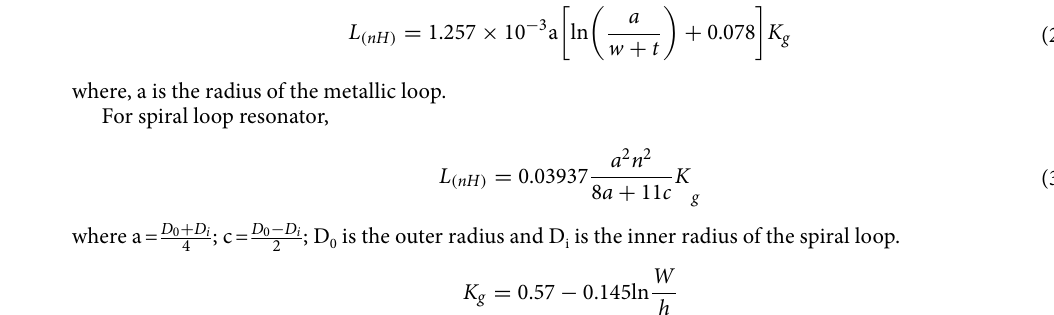
resonator and one spiral resonator is improved the electric and magnetic polarisation which enhance the nega- tive electric and magnetic susceptibility. The outer split ring resonator is loaded on the dielectric FR-4 substrate extended from 3.7 to 4.2 mm with the split 0.3 mm and the inner ring is deployed with the distance of 0.9 mm where the width of the metallic arm is 0.5 mm. The two split ring resonator is introduced the inductive and capacitive response with the interaction of the time varying electric and magnetic field. The split portion of the inner ring has a width of 0.3 mm. spiral loop metallic resonator is introduced on the middle part of the design with a distance of 0.45 mm from the inner split ring resonator. The complementary ring resonator is used as the outer metallic loop with an inner spiral type resonator which is introduced to the resonant frequencies. The combination of the spiral shaped metallic layer and two split ring resonator enhances the magnetic coupling with the subwavelength based metamaterial structure. Inductive properties of metallic layer dominate over the capacitive value of dielectric substrate in the higher frequency region. The metallic layer of copper exhibit the inductive response, whereas the dielectric substrate and the space between the metallic arm, are responsible for the capacitive response 28 . This subwavelength based metamaterial based resonator act as an LC resonant circuit